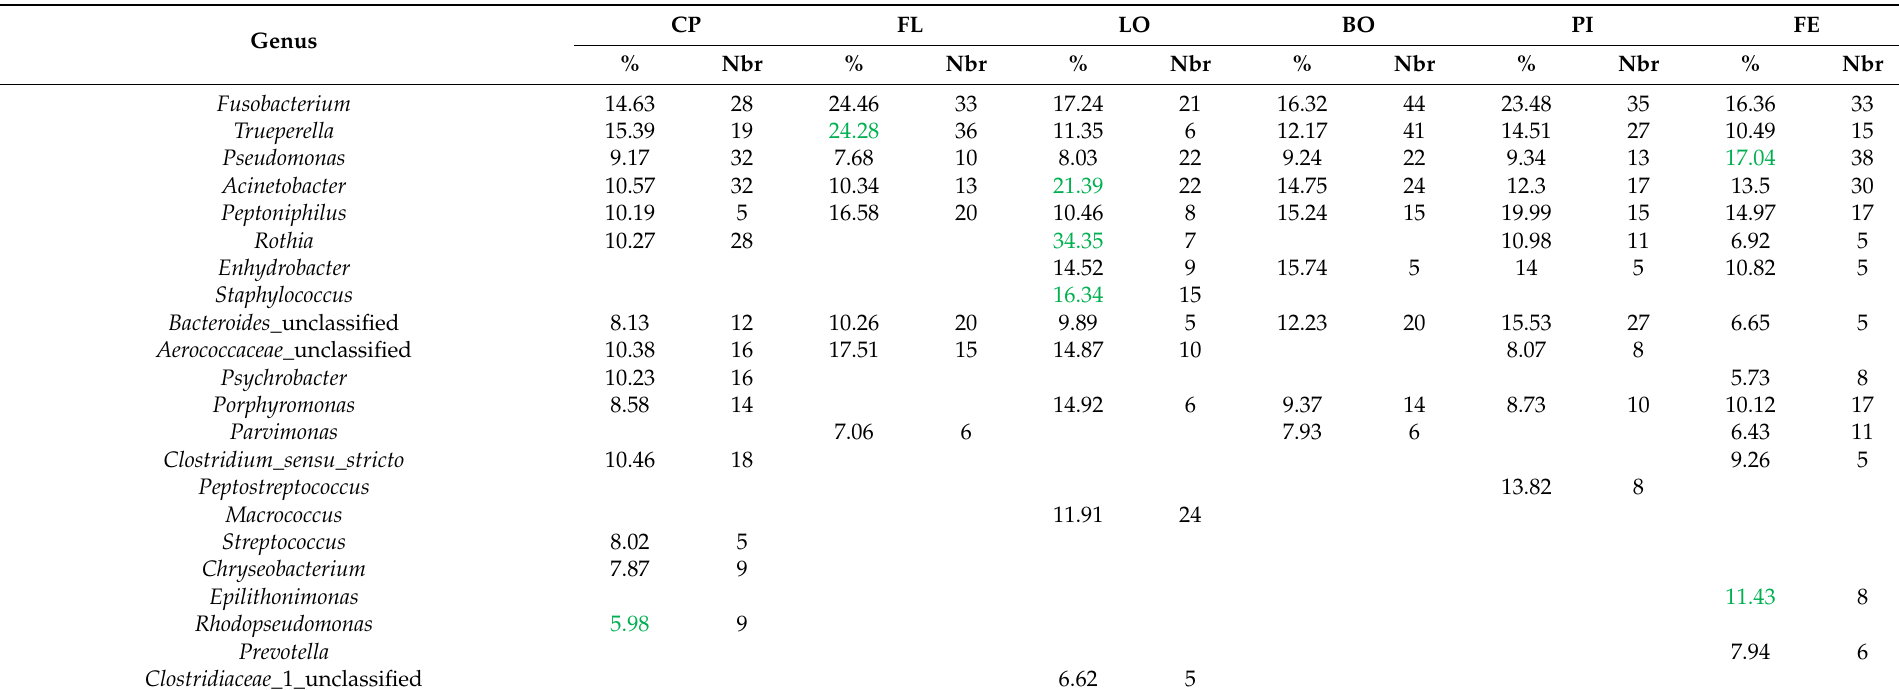
Table 2. Bacterial genera with an average relative abundance equal to or greater than 5% according to the six production lines and independent of visit.